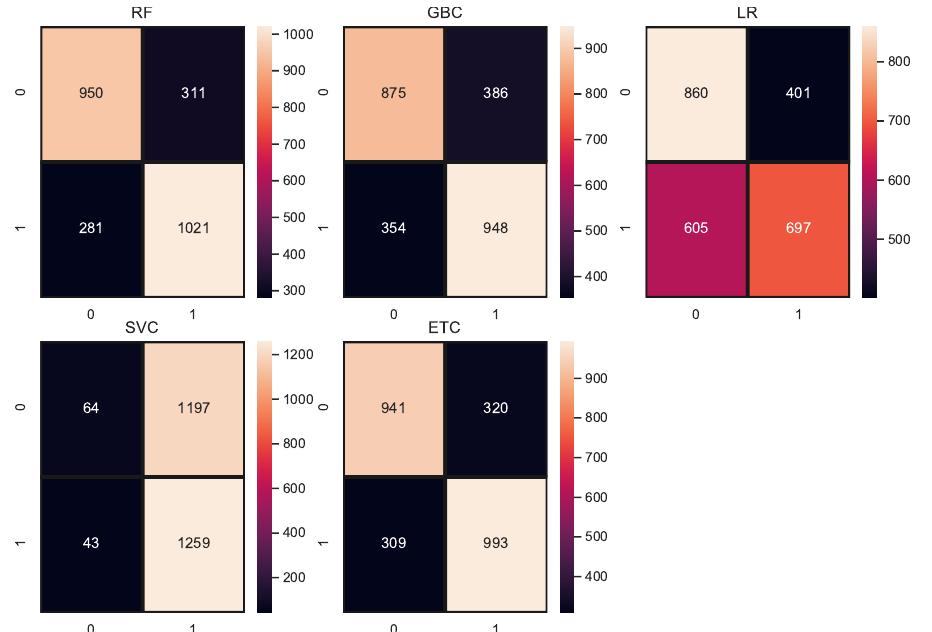
Figure 5. Confusion matrices of all models using original